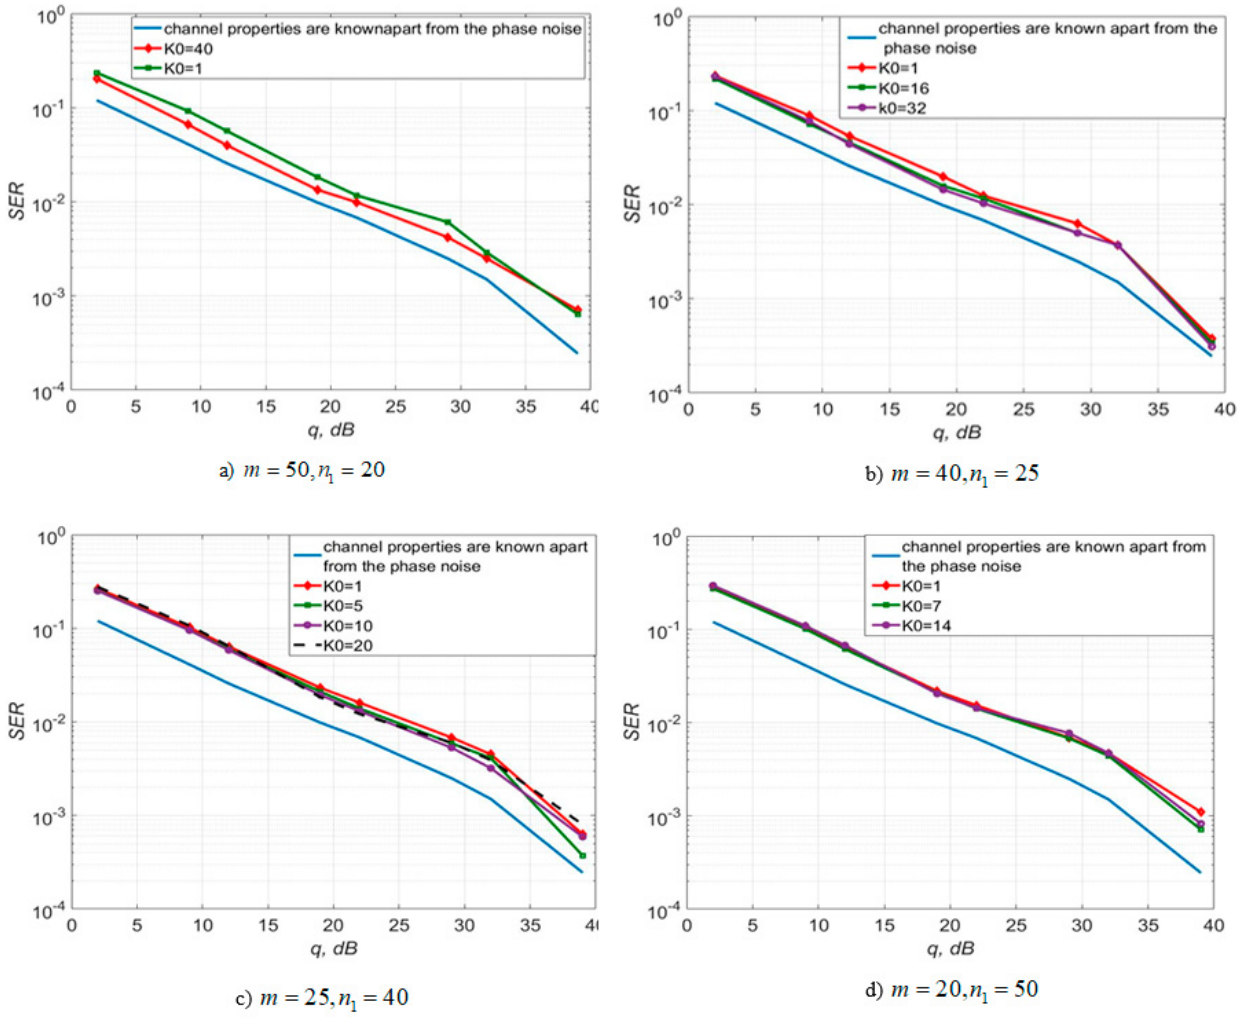
Figure 3. SER of 4-QAM versus SNR per bit for the algorithms, described by Equations (5)–(9) and (12) with polynomial approximation of the first order for different values of m and K 0